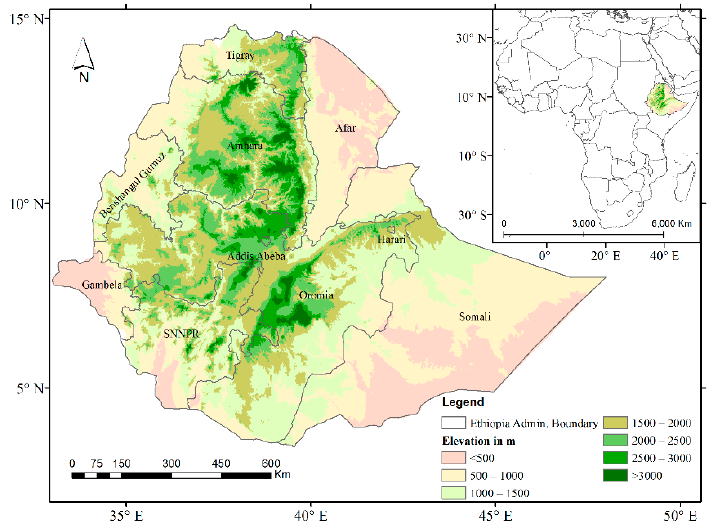
Figure 1. Location of the study area: the administrative boundary of Ethiopia, constituting the nine regional states, with a background showing an Advanced Spaceborne Thermal Emission and Reflection Radiometer digital elevation model of 30 m resolution.